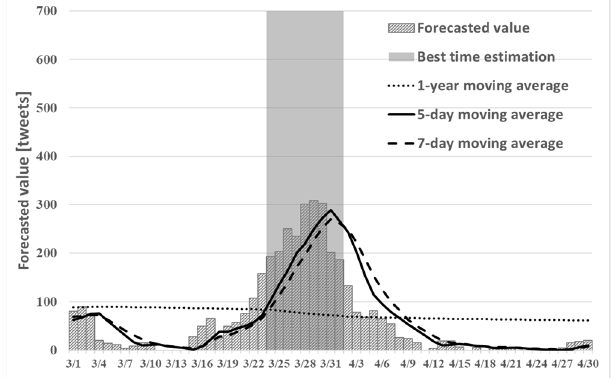
Figure 5. Tokyo after forecasting in 2019 (proposed method (1)).